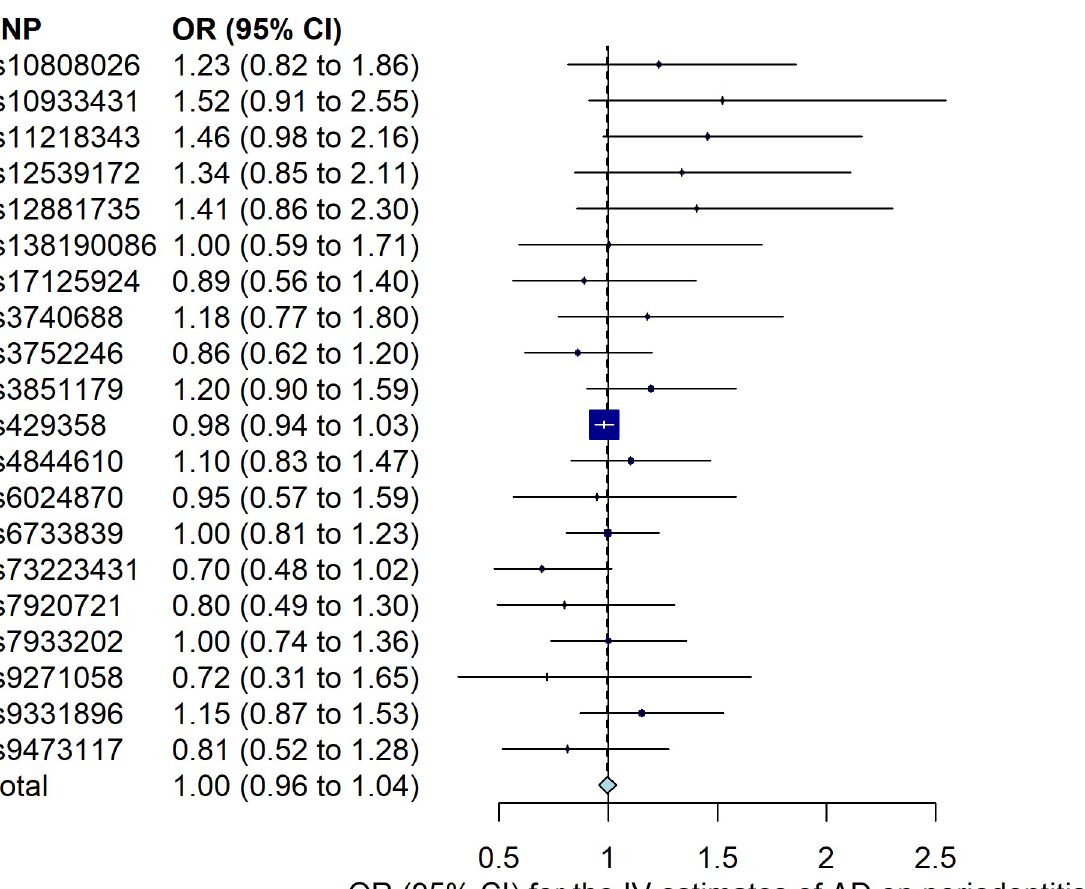
Fig 2. Mendelian randomization (MR) estimate for the risk of periodontitis associated with Alzheimer’s disease. MR estimate was calculated using the inverse-variance weighted (IVW) method to summarize the effect from each individual single-nucleotide polymorphism (SNP) in a random effects model. Odds ratio (OR) represents the risk of periodontitis per genetically determined 1-unit increase in ln (OR) of Alzheimer’s disease. 95% CI: 95% confidence interval of the odds ratio. AD: Alzheimer’s disease; IV: instrumental